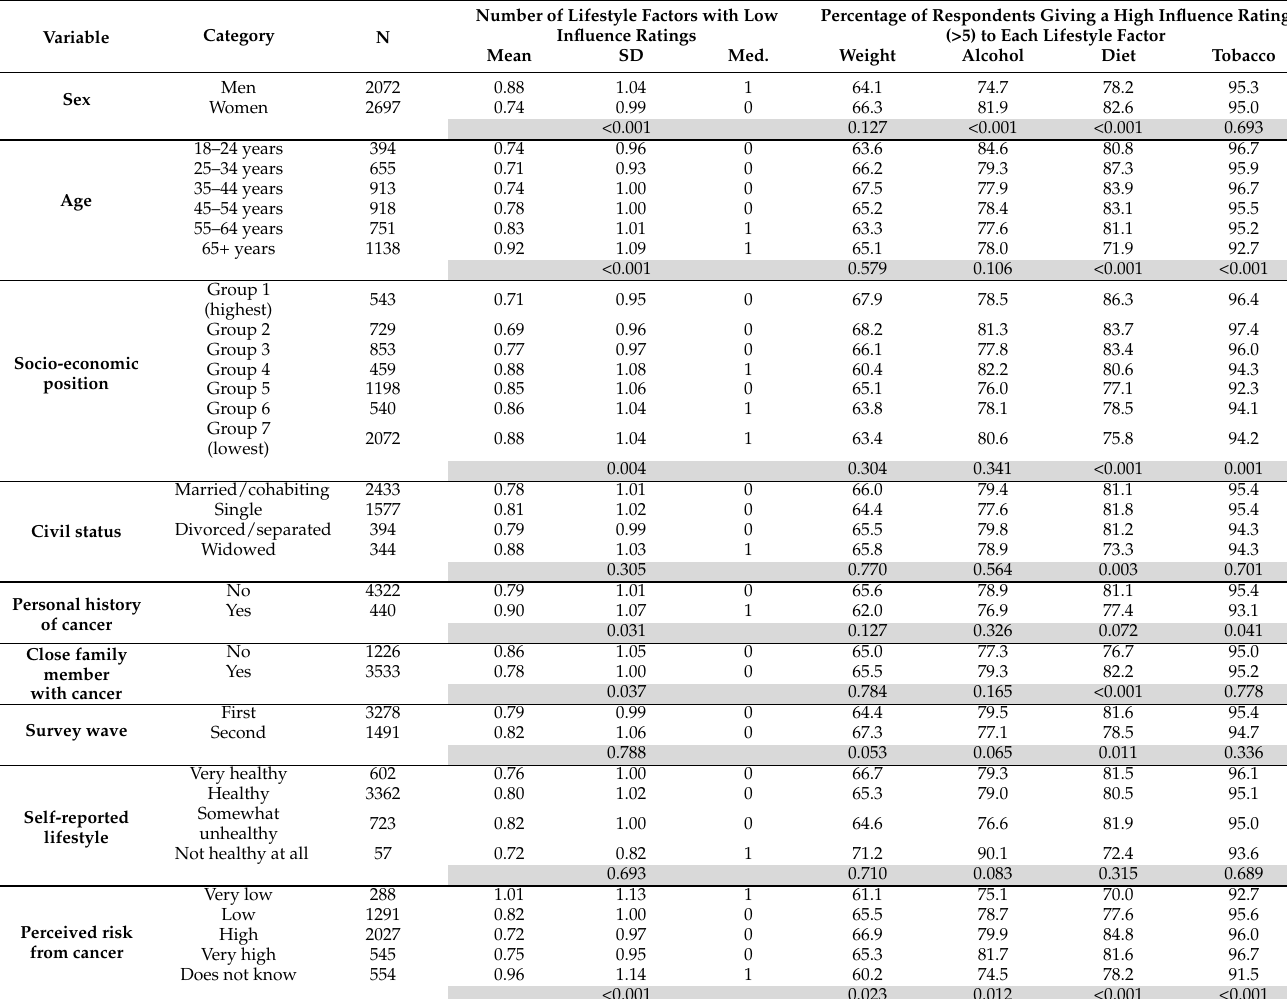
Table 2. Influence ratings according to socio-demographic groups and other variables. Note: SD = standard deviation; Med. = Median. Values in the grey rows are p -values based on Wilcoxon or Kruskal–Wallis tests in the case of the number of lifestyle factors with low ratings and chi-square tests in the case of the variables designating the percentage of respondents giving high influence ratings (weight, alcohol, diet, and